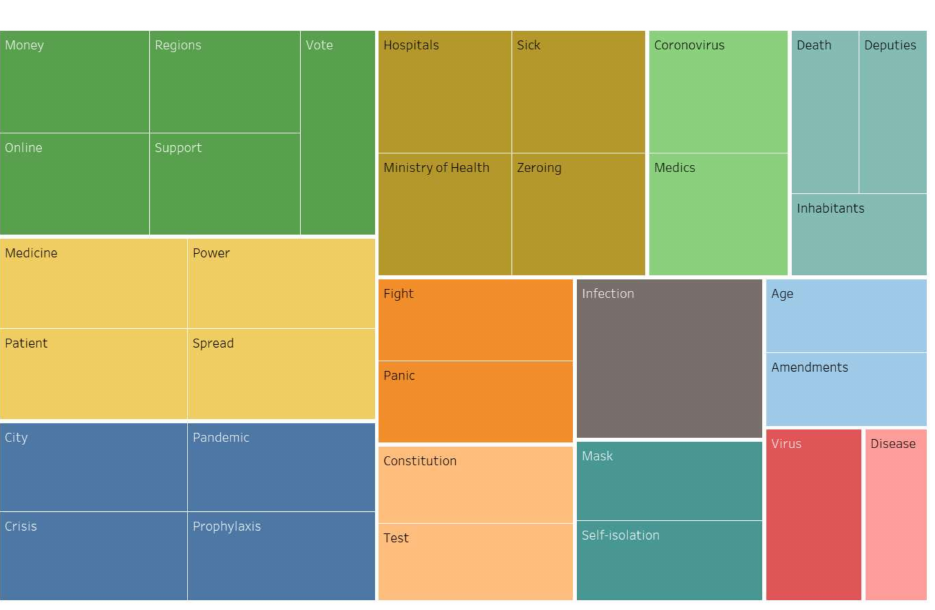
Figure 8. Core of the semantic network of the Moscow actors’